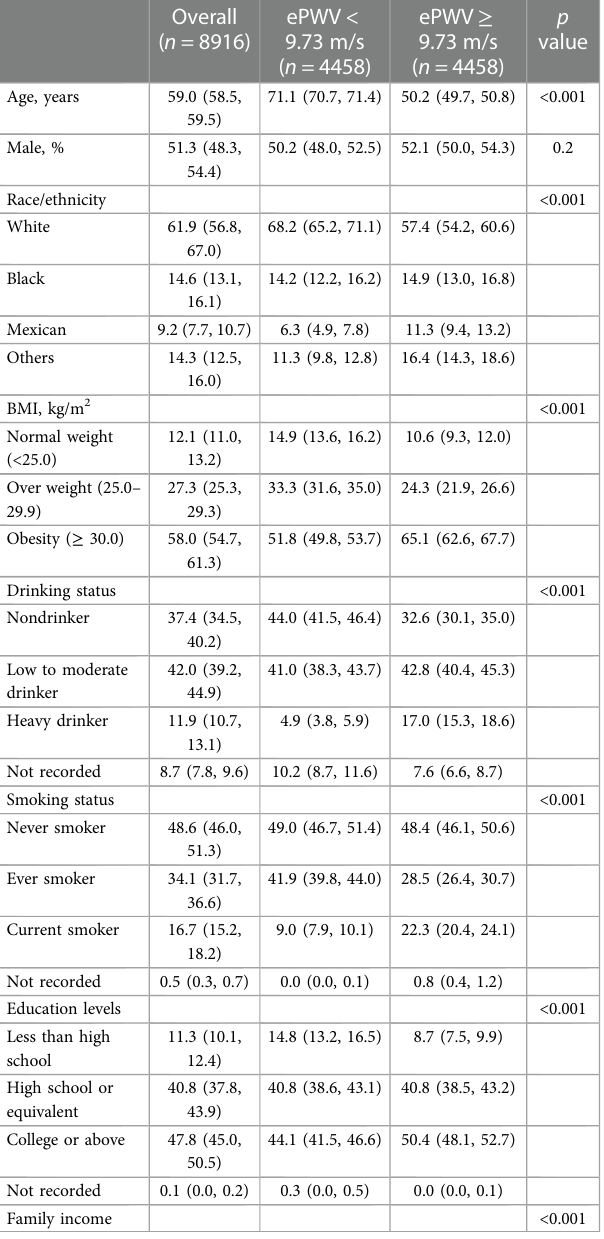
TABLE 1 Baseline characteristics of study